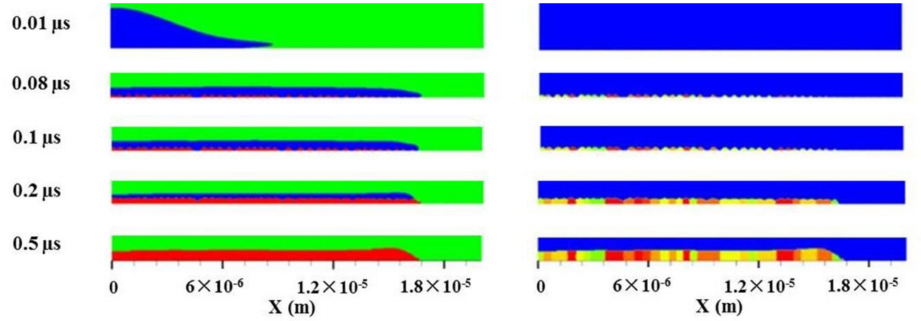
Figure 7. Flattening and solidification with crystallization process of refinement droplet at 518 m / s. (the green representing gas, the blue liquid, the red solid, respectively, and the di ff erent colors indicating di ff erent orientations of column grains).